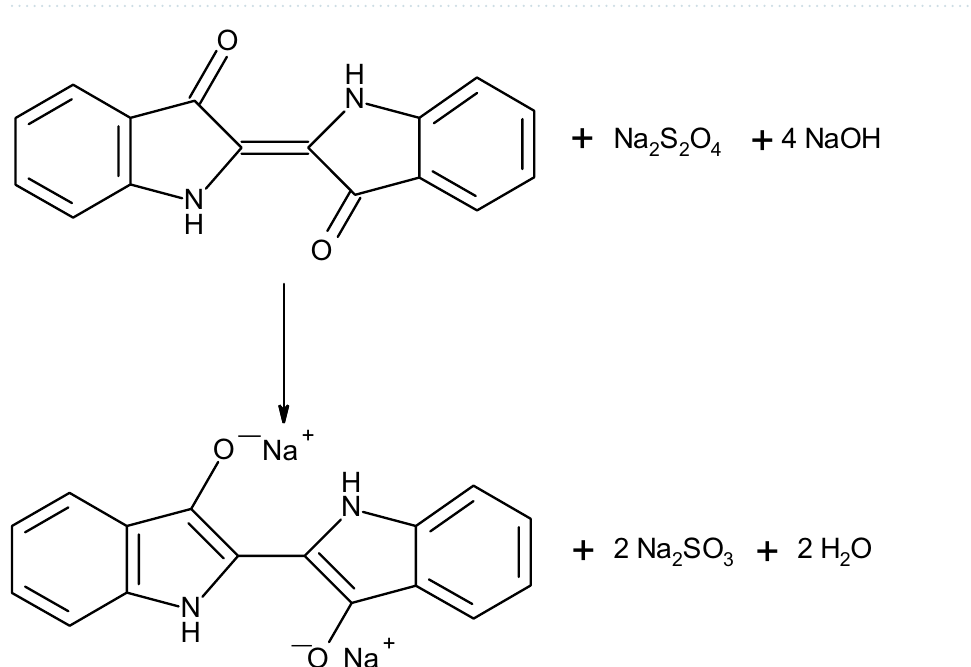
Figure 1. Principal synthesis route of indigo with aniline as starting material according to Pfleger and Heumann 3 .